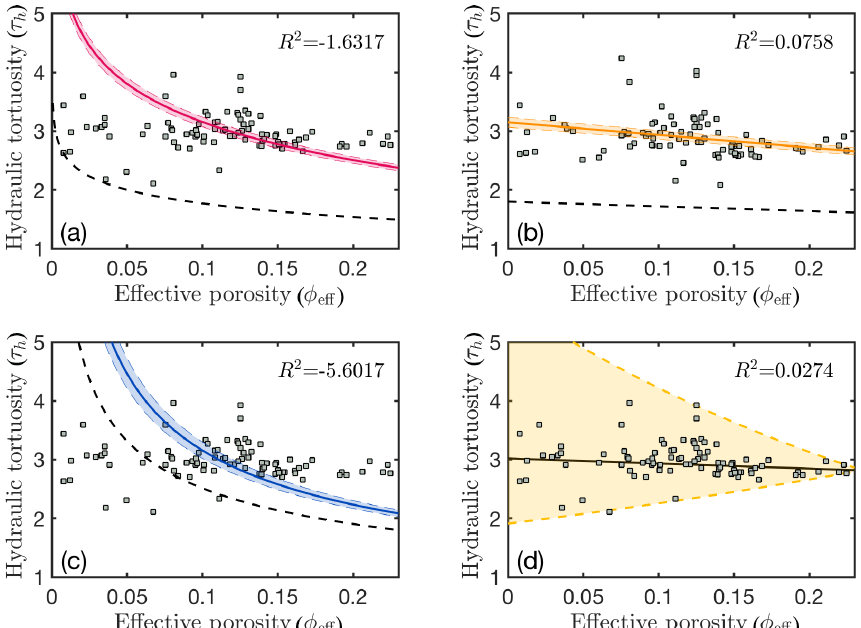
Figure 4. Panels (a) – (c) show the proposed relations for the hydraulic tortuosity according to (a) Matyka et al. (2008), (b) Koponen et al. (1996) and (c) Mota et al. (2001) as black dashed lines. The coloured solid lines represent the fit of the computed data to those relations within the 95% confidence bounds. Hydraulic tortuosities for all subsamples (grey squares) are computed according to the method used in each of these studies. Panel (d) shows the fit obtained in the present study. The coloured area in (d) illustrates the extending distribution of computed hydraulic tortuosities with decreasing effective